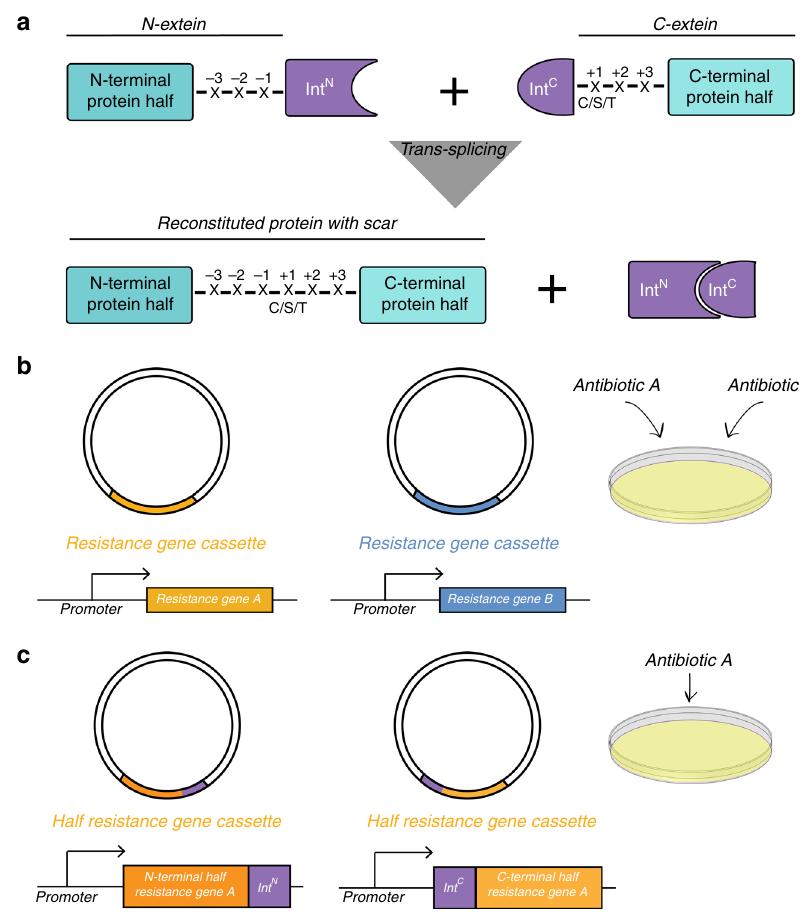
Fig. 1 Cells containing two plasmids can be selected with a single antibiotic. a Schematic showing trans- splicing of proteins by a split intein. X any amino acid, C cysteine, S serine, T threonine. b , c Schematic highlighting the difference between the conventional ( b ) and the SiMPl ( c ) selection